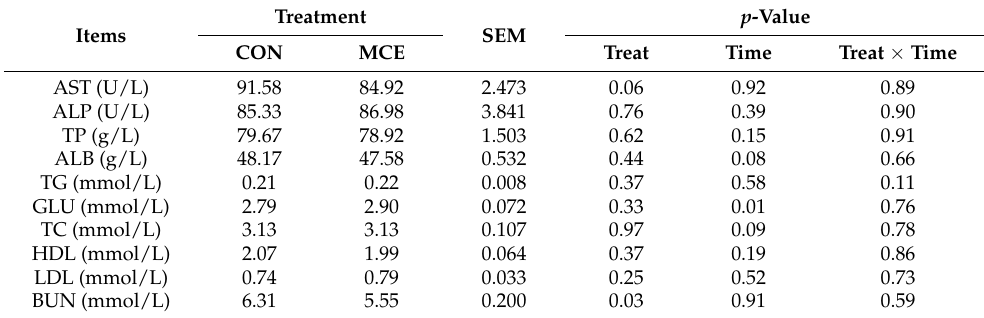
Table 7. Effects of MCE on plasma